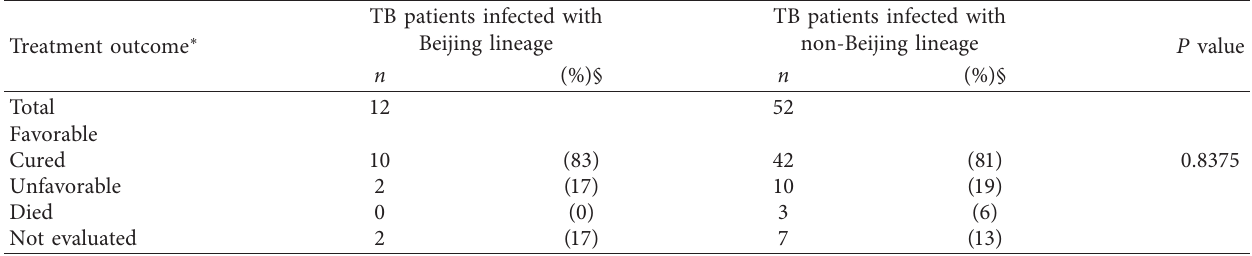
Table 4: Comparison of treatment outcome of 64TB patients diagnosed in a tertiary care hospital in Kandy, Sri Lanka, between February 2018 and March 2019 disaggregated by their Beijing lineage strain status. Treatment outcome